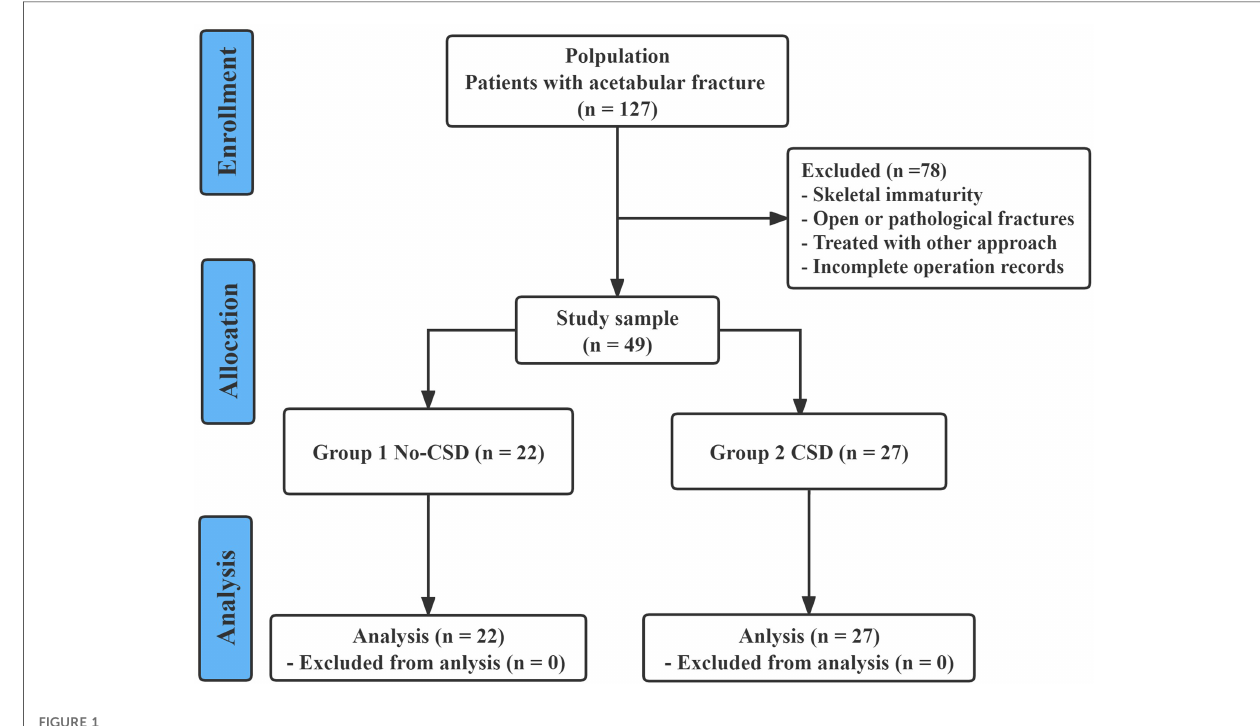
FIGURE 1 The fl owchart of the patient screening process.